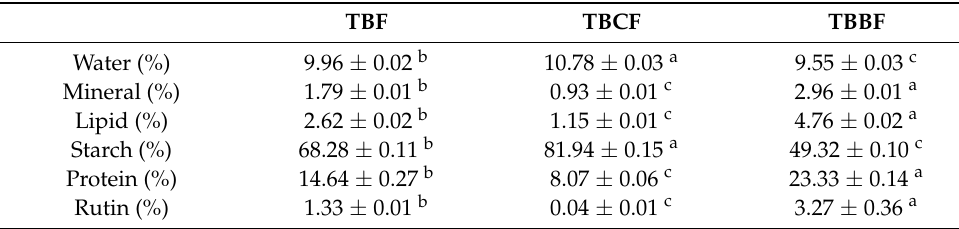
Table 1. Chemical composition of TBF, TBCF, and TBBF.